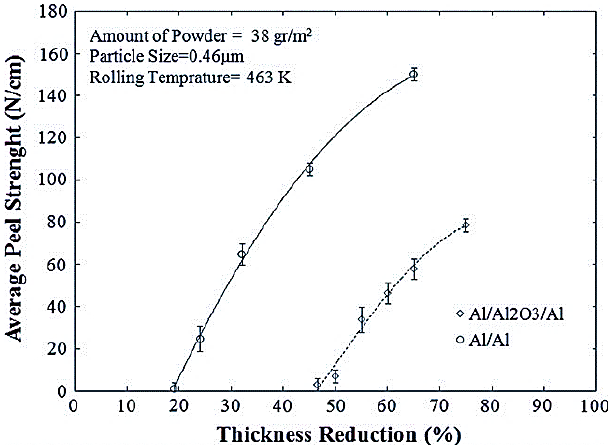
Figure 9. Average peel strength versus the thickness reduction [54].